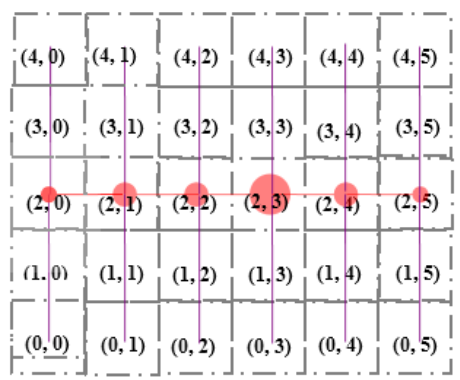
Figure 8. SH of 13th Sector implies Algorithm 3 in order to convert the 5 × 5 grid into a tree rooted at 13th ( 2, 3 ) Sector.